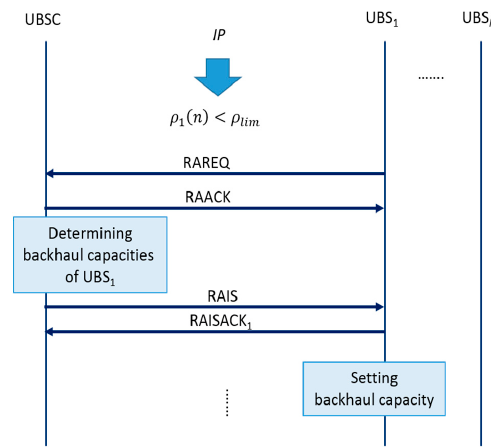
Figure 4. Under-utilization case of the normal operation phase. IP: initialization phase; RAREQ: Resource Reallocation Request; RAACK: Resource Reallocation Acknowledgement.